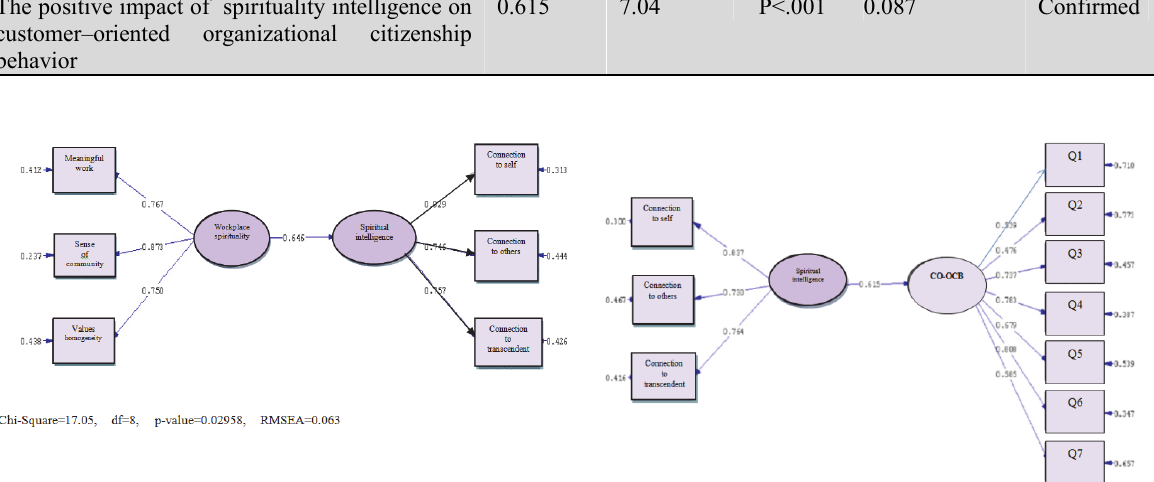
Fig. 4. the estimation model of the impact by “spiritual intelligence” on